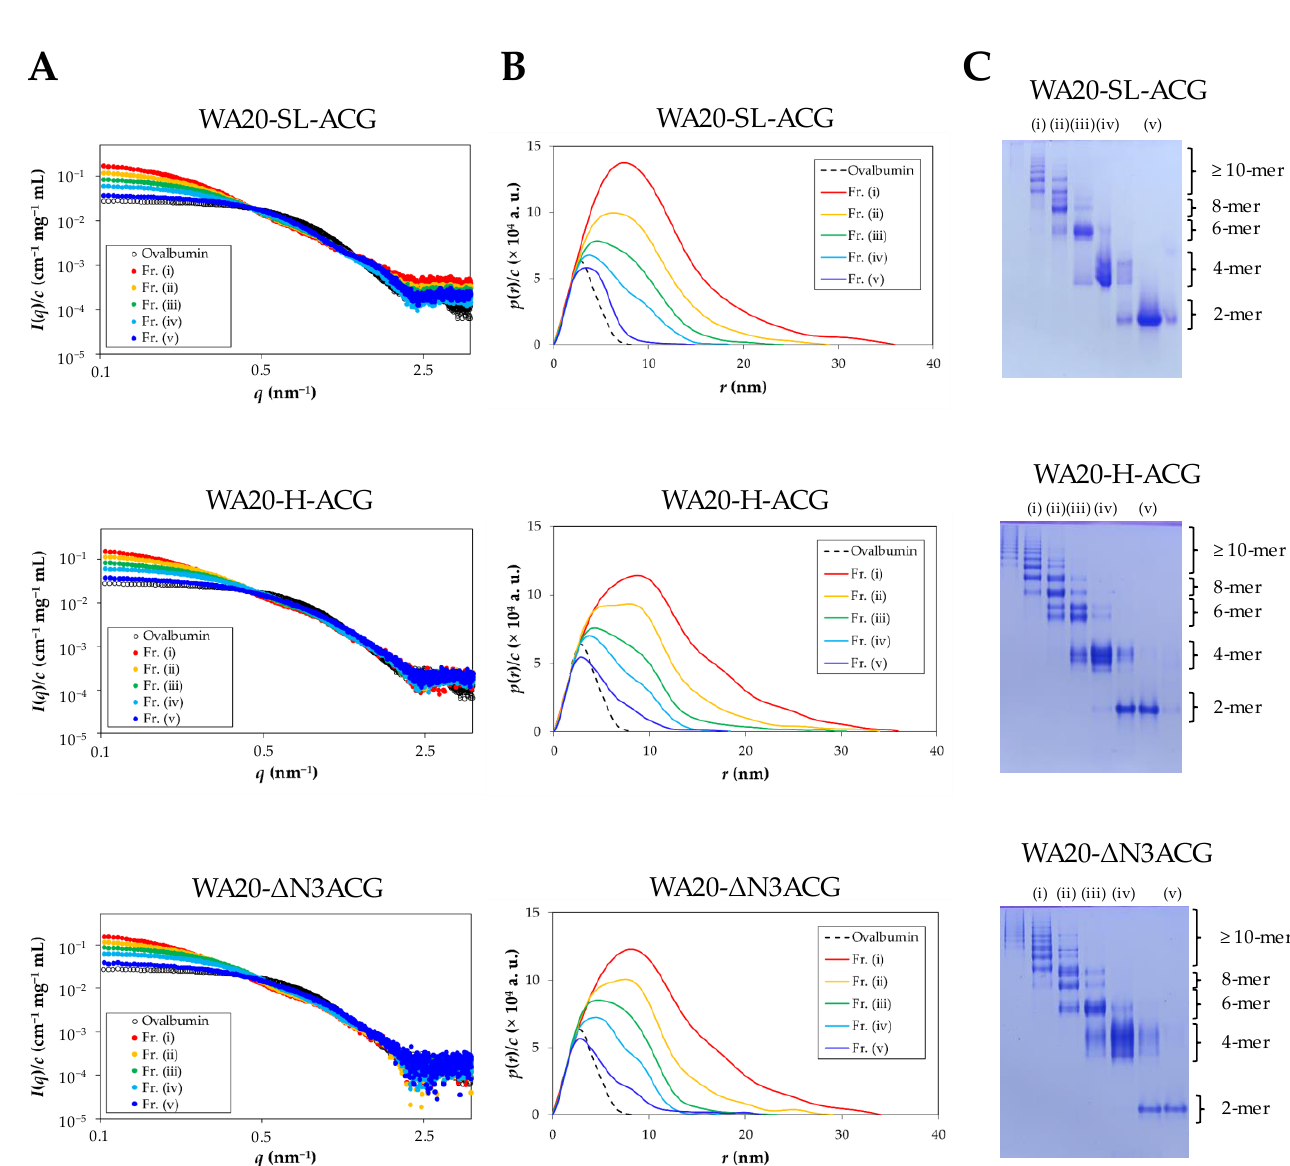
Figure 3. SAXS analysis. ( A ) Concentration-normalized absolute scattering intensities of the frac- tionated samples (Fr.) of WA20-SL-ACG, WA20-H-ACG, and WA20- ΔN3ACG. Ovalbumin was used as a reference standard of the molecular mass. ( B ) Concentration-normalized pair-distance distribution functions of WA20-SL-ACG, WA20-H-ACG, and WA20- ΔN3ACG obtained by inverse Fourier transforming the SAXS data. ( C ) Native PAGE analysis of the samples fractionated by SEC purification for the SAXS experiments. Proteins were stained with Coomassie brilliant blue. The oligomeric states of the protein bands were estimated from the SEC – MALS results.